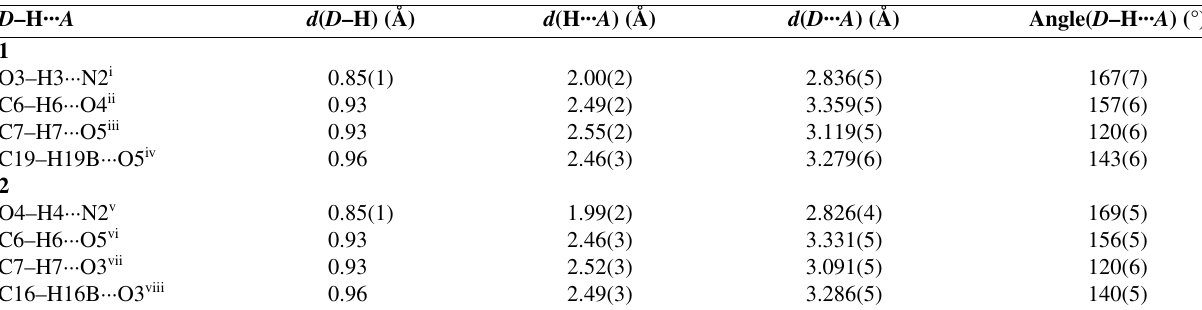
Table 3. Hydrogen Bonding for the